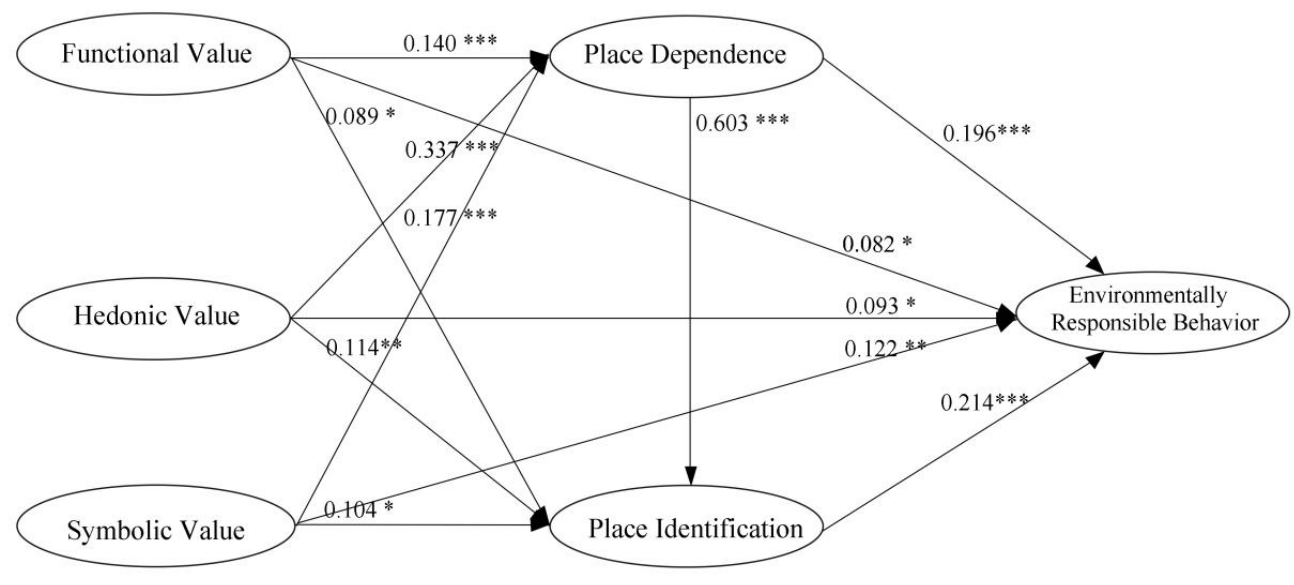
Figure 2. Results of the structural equation model (NOTE: ***, ** and * indicate p is significant at 0.001, 0.01 and 0.05 levels of significance, respectively).